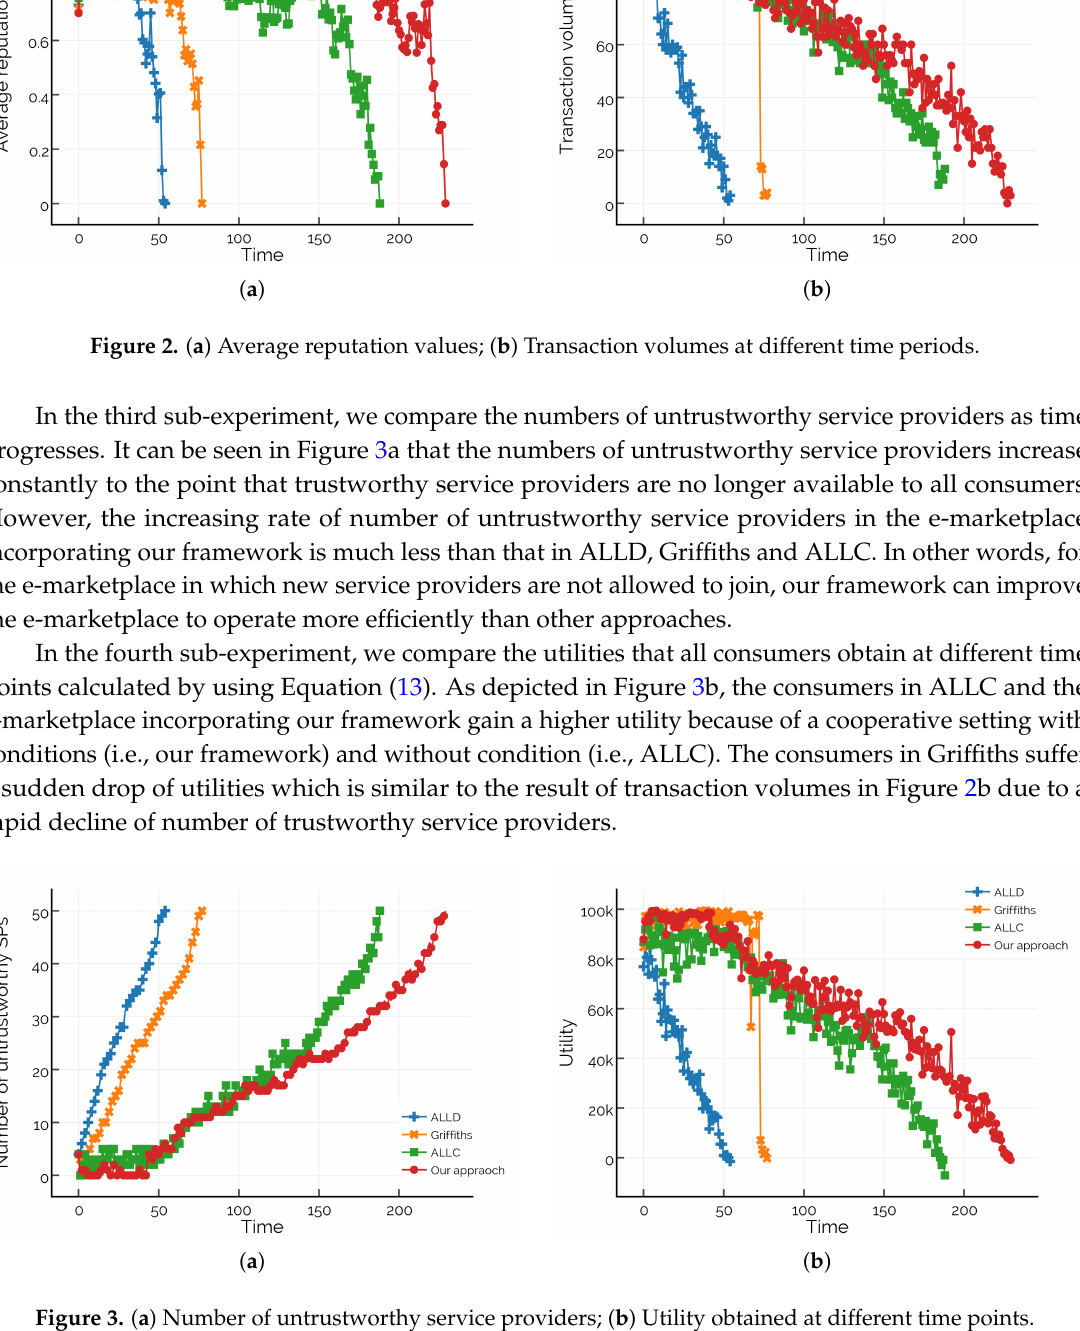
Figure 3. ( a ) Number of untrustworthy service providers; ( b ) Utility obtained at different time